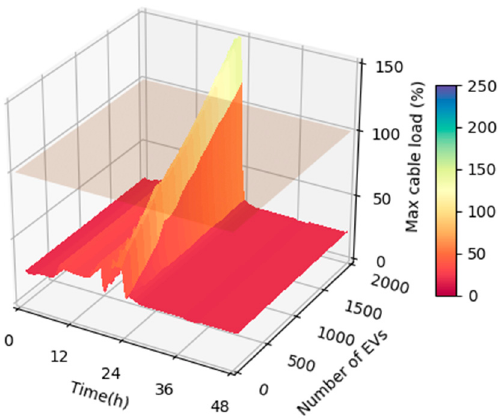
Figure 14. The maximum cable loading in Scenario 4 in the upper feeder for different numbers of EVs.